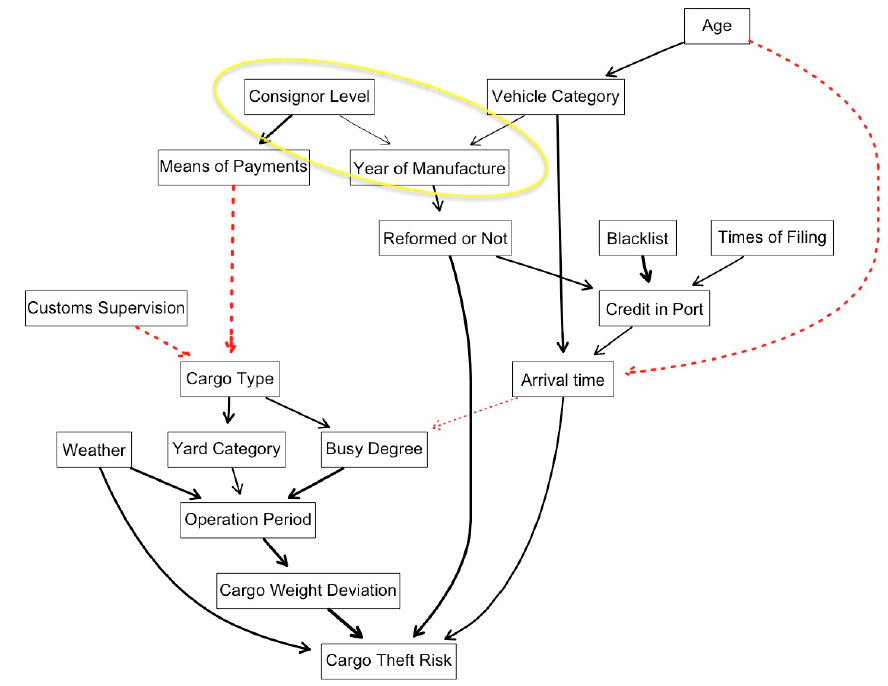
Figure A4. The Bayesian network structure derived using combinations of heuristic structure search algorithm with TABU and score function with Aic .